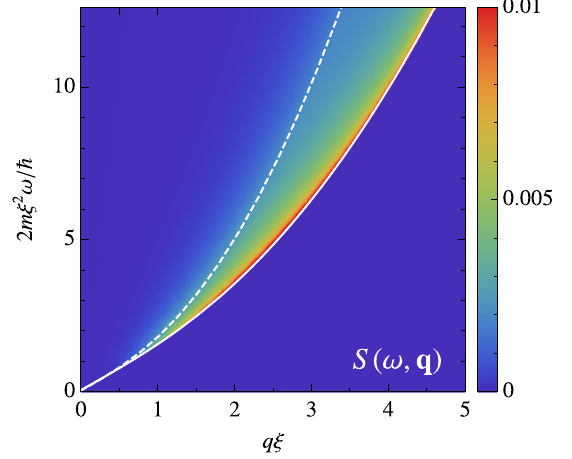
FIG. 7. Density plot of the dynamic structure factor as predicted by the T -matrix approximation of Sec. V. The response starts above a two-phonon threshold ℏ ω ¼ 2 E q indicated by the = 2 white continuous line. The position of the coherent Bogoliubov peak at ℏ ω ¼ E q is shown by a white dashed line.